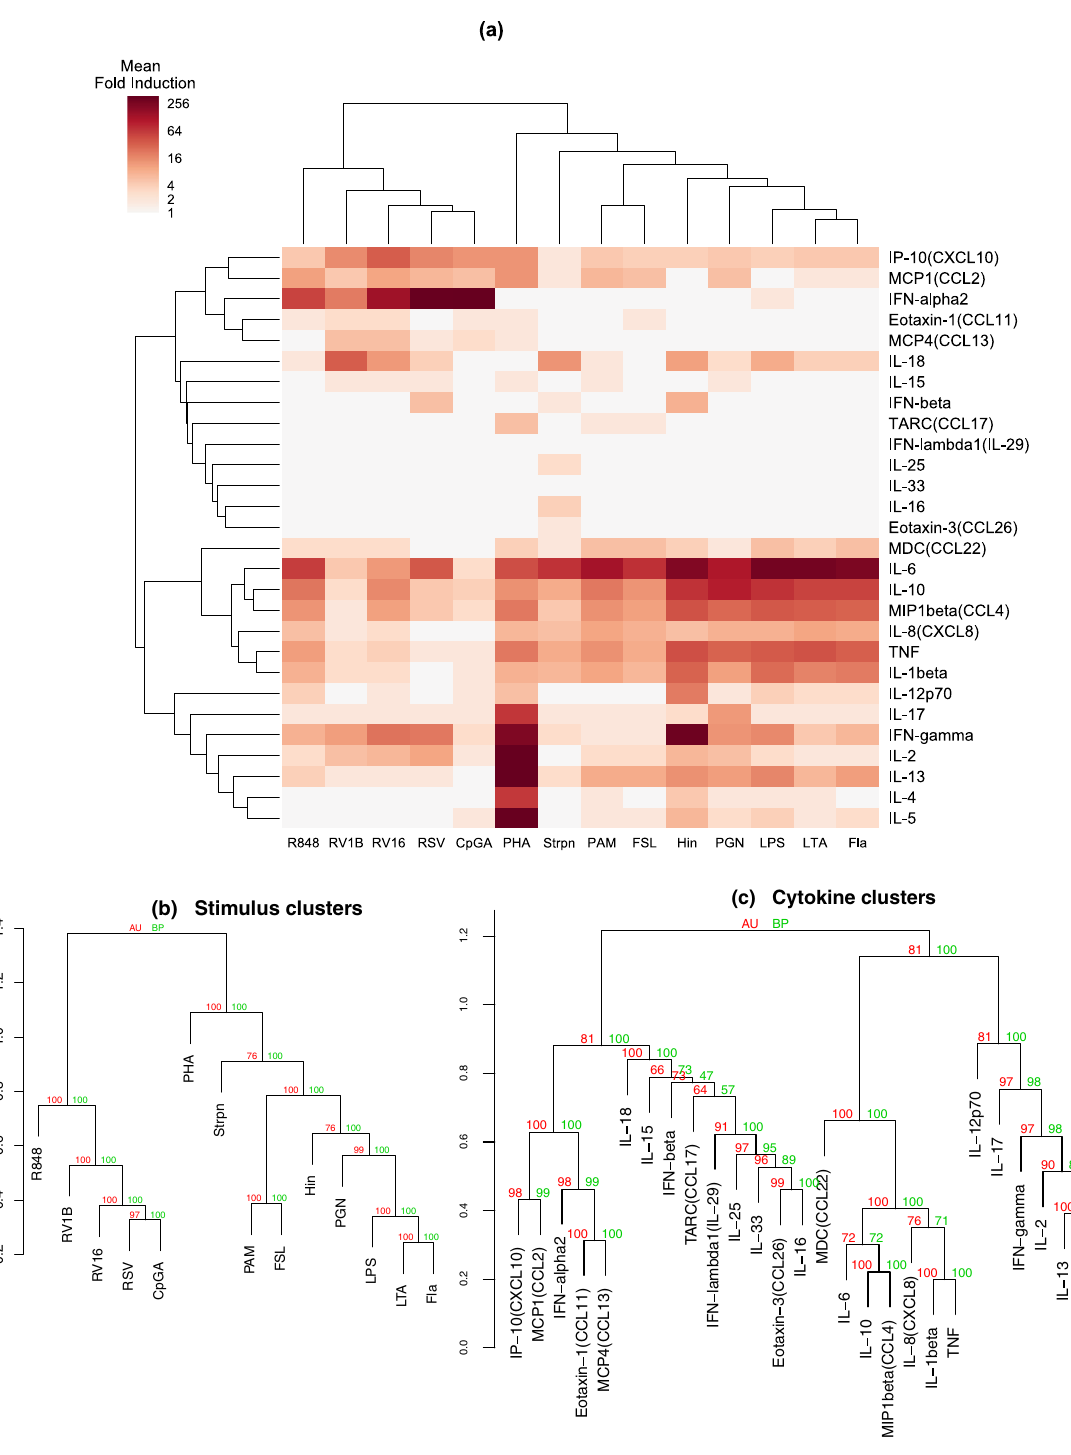
Figure 2. Hierarchical clustering (HC) of cytokine responses. ( a ) Heatmap of the mean level of response for each cytokine-stimulus pair (307 children, media-normalised). ( b ) Hierarchical tree for stimuli. ( c ) Hierarchical tree for cytokines. Values on nodes indicate probability values (%) of the found clusters appearing in bootstrap resampling. Green numbers are estimates from ordinary bootstrap probabilities (BP); red numbers are “approximately unbiased” (AU) estimates from multi-scale bootstrap resampling, which are less biased estimates than BP (see “Methods” section). Plot ( a ) was generated using seaborn package in Python (version 3.8, https:// www. python. org/). Plots ( b,c ) were generated using pvclust package in R (version 3.6.3, https:// www.R- proje ct.